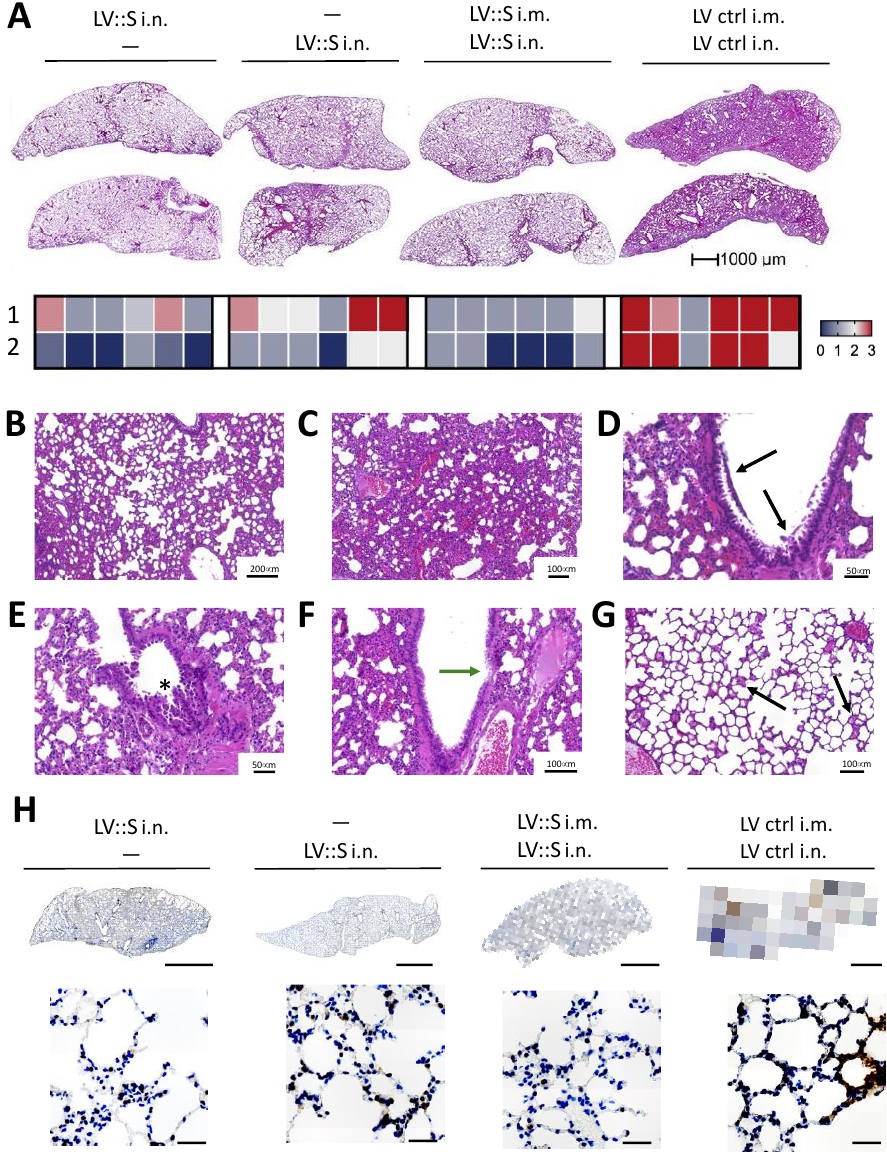
Figure 4. Single i.n. LV:: S injection largely reduced lung histopathogy. ( A ) Lung histological H&E analysis, as studied at 4 dpi. Heatmap recapitulating the histological scores, for: (1) inflammation score and (2) interstitial syndrome. ( B ) Representative alveolo-interstitial syndrome and ( C ) severe inflammation in an LV ctrl-injected and infected hamster. Here, the structure of the organ is largely obliterated, while remnants of alveolar spaces and bronchiolar lumens can be seen. ( D – F ) bronchiolar lesions in LV ctrl-immunized animals. Shown are epithelial cells and cell debris in the bronchiolar lumen (black arrows) ( D ), papillary projections of the bronchiolar epithelium into the lumen (star) ( E ) and degenerative lesions with effacement of the epithelium (green arrow) ( F ). ( G ) Mild alveolar infiltration in a vaccinated hamster. Some of the alveoli (arrow) are partially or completely filled with cells and an eosinophilic exudate. ( H ) Representative N CoV-2 -specific IHC image performed on lungs of SARS-CoV-2-infected hamsters. Lower panels show enlarged views from upper panels. Scale bars are 1 mm for upper panels and 25 μm for lower panels.